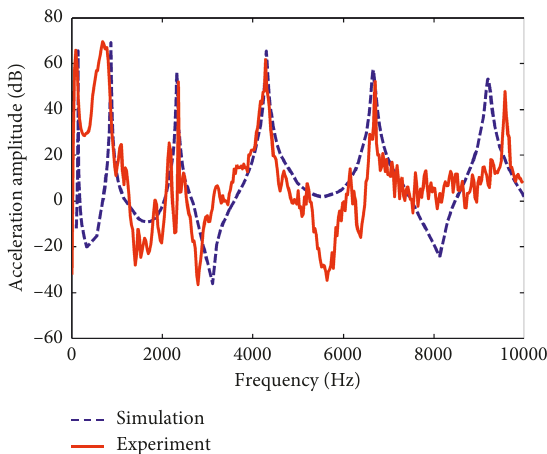
Figure 15: Comparison between the numerical simulation and the experimental